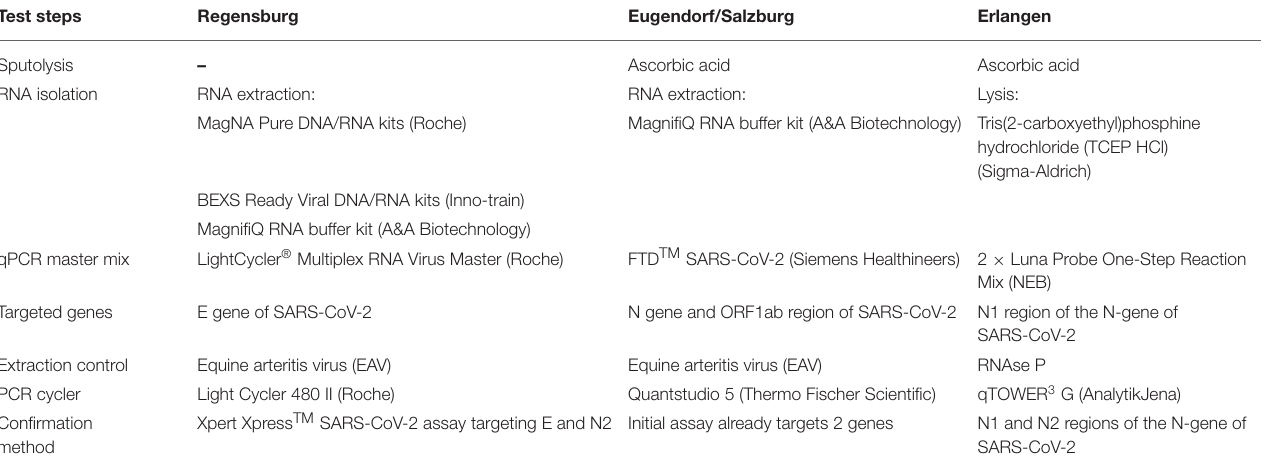
TABLE 1 | Comparison of PCR test methods in WICOVIR laboratories in this study